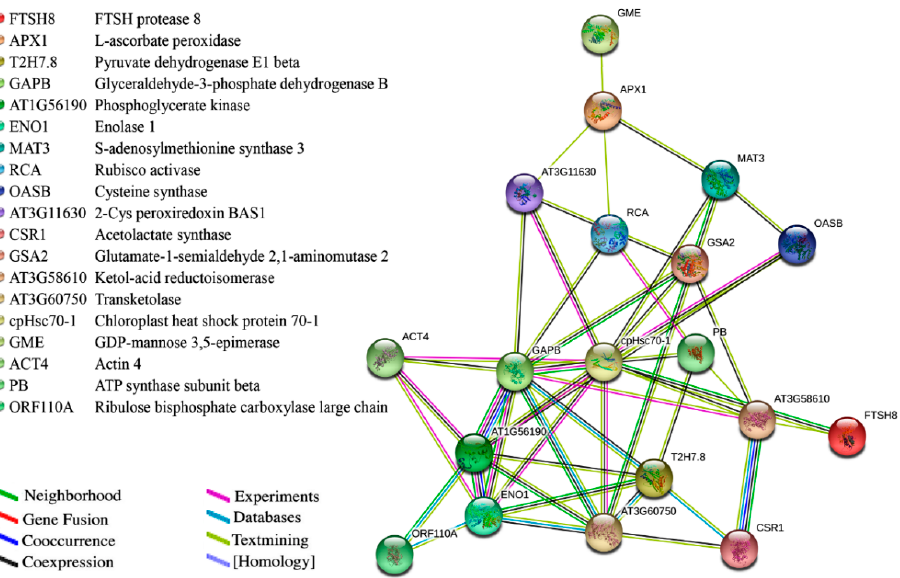
Figure 4. Protein-protein interaction network of differentially accumulated proteins analysed by STRING 10.